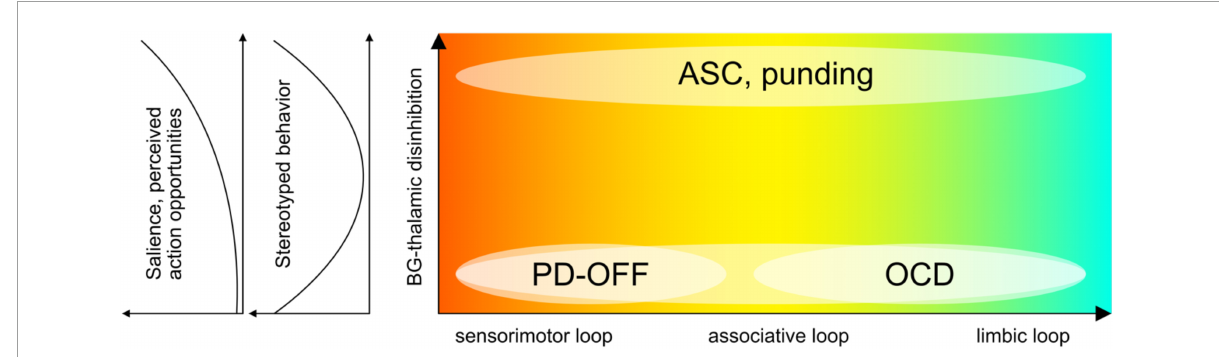
FIGURE7 Externally versus internally weighted dynamics shown against the different parallel basal ganglia loops. Stratification of stereotyped behaviors along parallel cortico-basal ganglia loops ( x -axis) and level of thalamic disinhibition by basal ganglia output ( y -axis). Lower BG-thalamic disinhibition corresponds to behavior determined more by top-down, prior models. This putatively shapes phenomena in OCD and PD-OFF. Note that beyond motor symptoms, PD-OFF can show severe cognitive and affective alterations as well. Higher BG-thalamic disinhibition corresponds to higher weighting of bottom-up sensory data, by disinhibiting thalamic matrix cells and flattening of the attractor landscape of cortical state space, thereby reducing state change resistance (Shine, 2020). Higher BG-thalamic disinhibition putatively shapes phenomena in ASC and